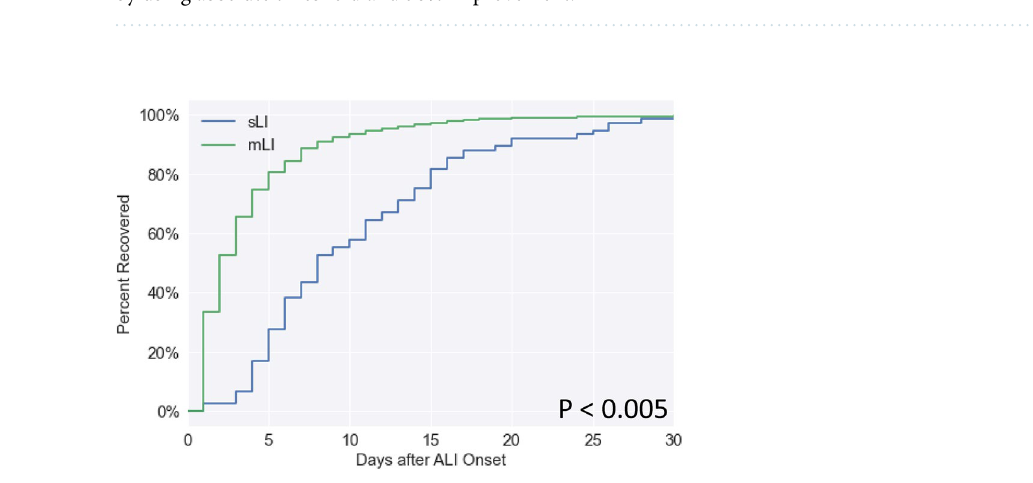
Table 3. Number of mLI and SLI patients recovered (A) at hospital discharge and (B) post discharge defined by using absolute threshold and 50% improvement.